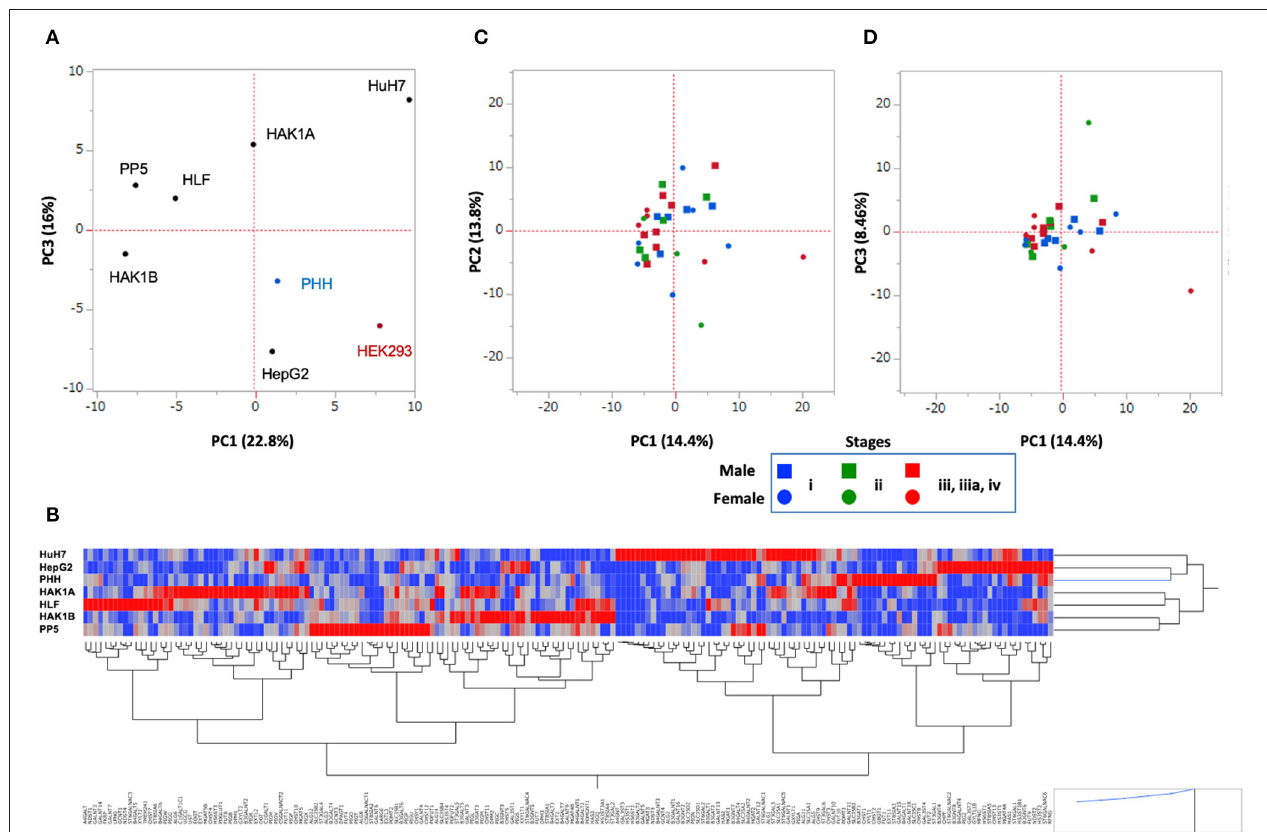
FIGURE 6 | Principal component analysis (PCA) of hepatic cancer cells. Data set of the expression of glycogenes from HCC cell lines (A,B) and HCC tissues from TCGA (C,D) . (A) Six HCC cell lines shown in the plot were analyzed. PHH and HEK293 were used as control cells. PC1 vs. PC3 is shown. (B) Cluster analysis of glycogenes expression from hepatic cells. Heat map of glycogenes expression is displayed as red (strong) to blue (weak), and gene symbols are indicated under a hierarchical clustering tree. PHH, HepG2, and HuH7 are closer in this analysis. (C,D) The expression of glycogenes obtained from 31 patients in the TCGA-LIHC project was analyzed and plotted. PC1 vs. PC2 is in (C) , and PC1 vs. PC3 is in (D) . Note: scale is different from A. Blue: Stage i, Green: Stage ii, Red: Stage iii, iiia, and iv; Square: male, Circle: